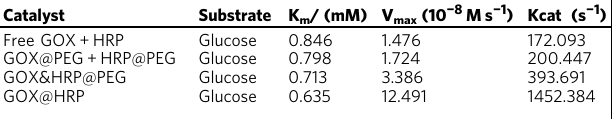
Table 1 Kinetic data for different tandem catalytic systems